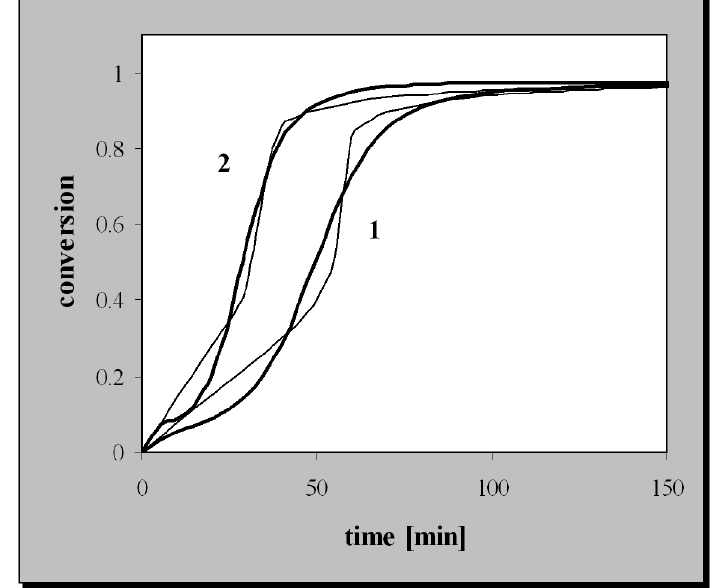
Fig. 16 Variation of monomer conversion with time for: (1) T = 70 o C and I 0 = 25.8 mol/m 3 ; (2) T = 70 o C and I 0 = 100 mol/m 3 ; thick lines - predictions on MLP (3:9:3:3), thin lines - kinetic model [18], [19].